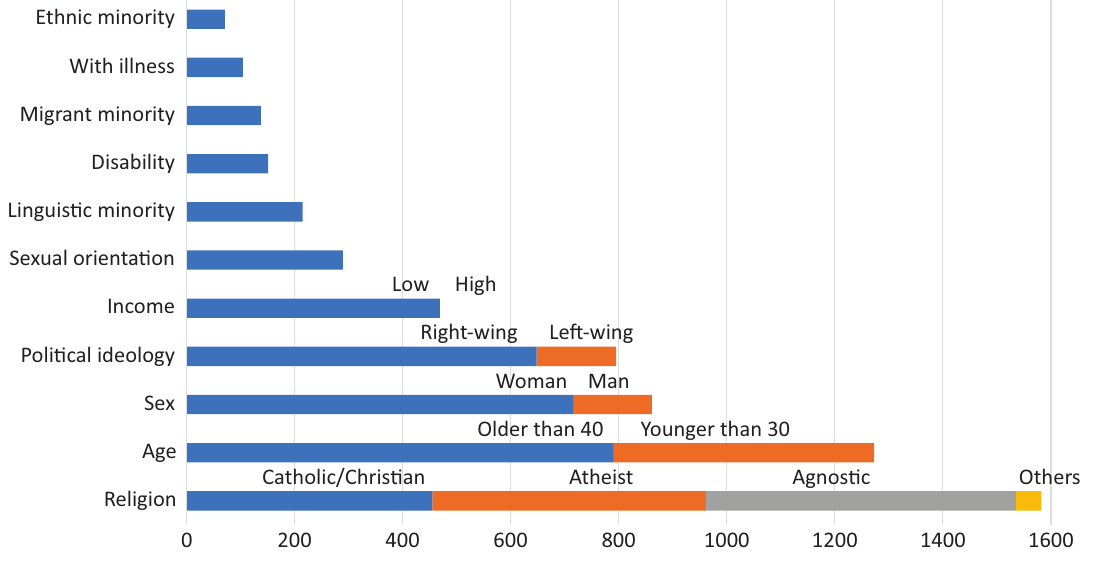
Figure 1. Identification with a group. Created from the data in Table